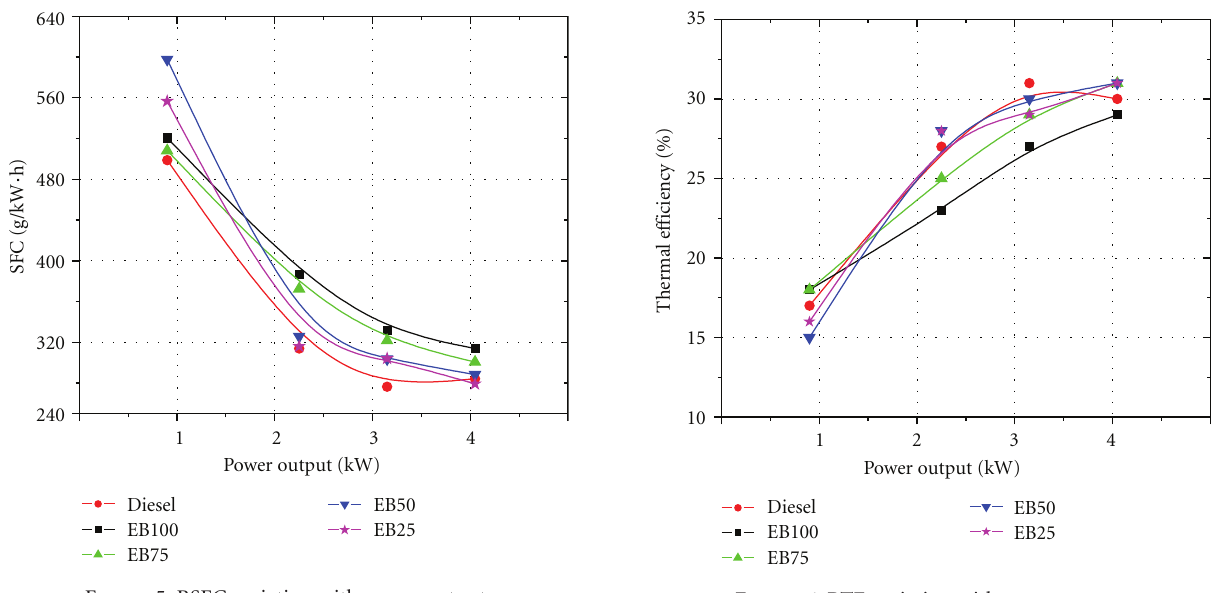
Figure 5: BSFC variation with power output. Figure 6: BTE variation with power